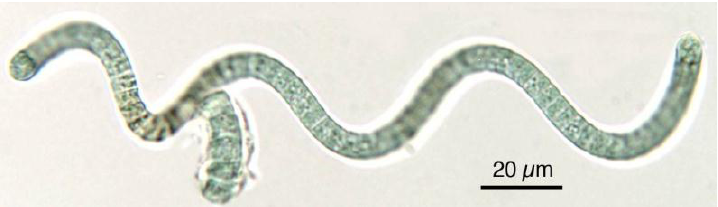
Figure 2. In Spirulina, cells are aggregated into filaments that tend to form spirals. Note the blue-green colour typical of cyanobacteria.